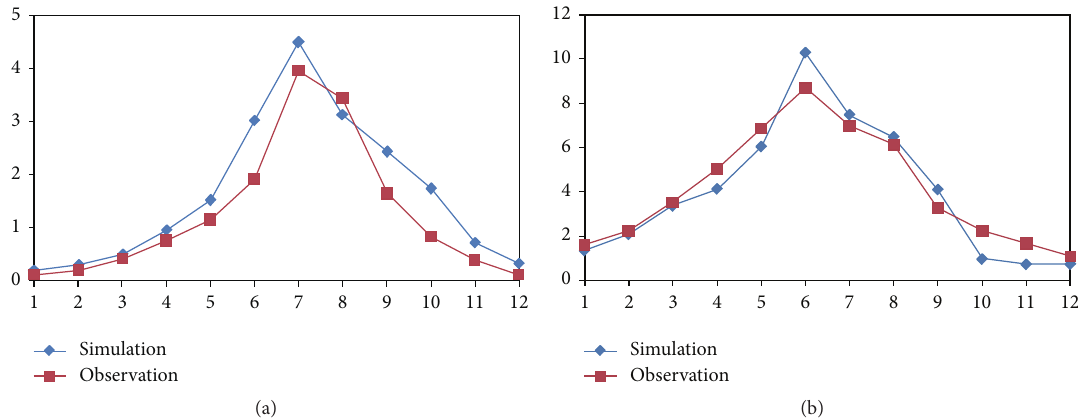
Figure 4: Comparison between RegCM4.1 simulated and CRU observed annual cycles of monthly precipitation (mm/day) regional